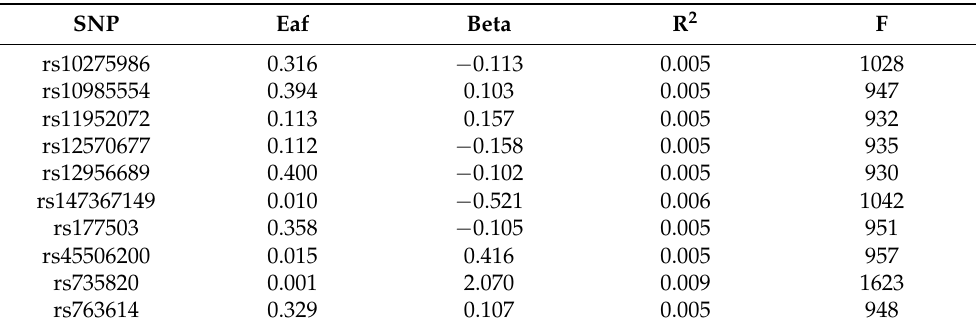
Table A4. The F statistics for SNPs strongly associated with irritable bowel